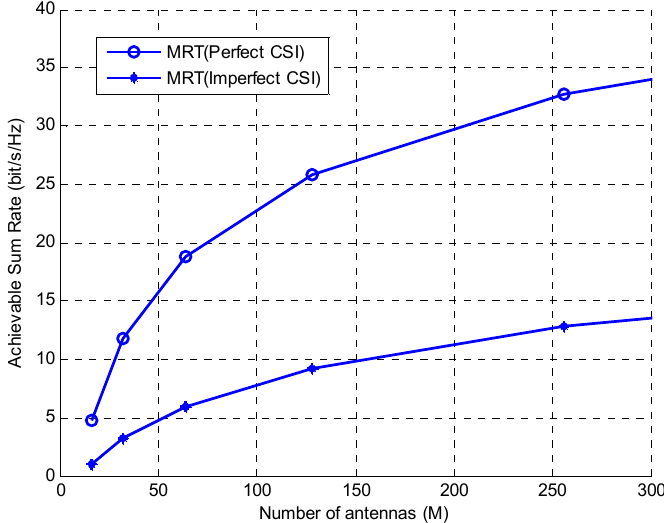
Figure 10. Achievable sum rate (bits/s/Hz) vs. the number of antennas (M) in multi-cell system with L = 7, K = 10, and transmit power = 10 dB.